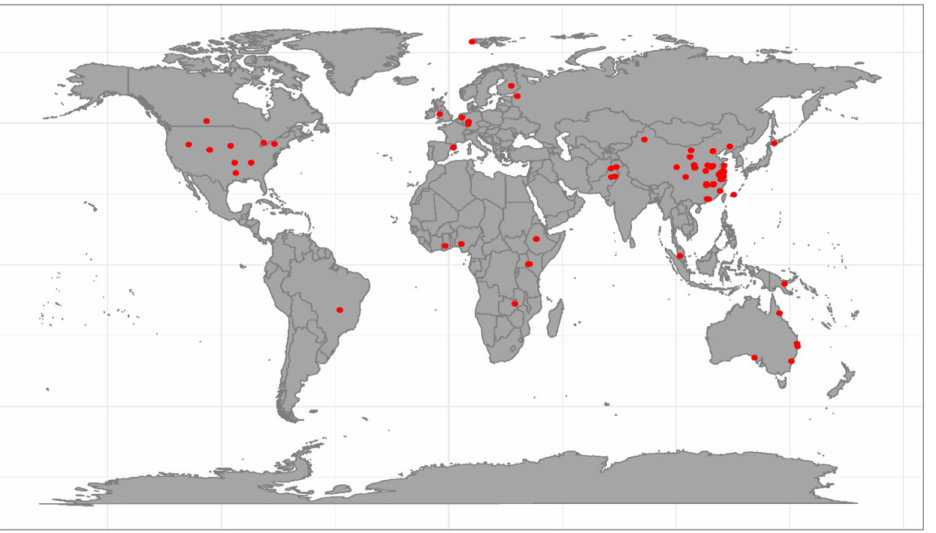
Figure 1. Global distribution of the data sampling sites for soil N dynamic parameters and crop productivity of global field experiments under biochar addition in this meta-analysis. The red points represent each data sampling site in the different